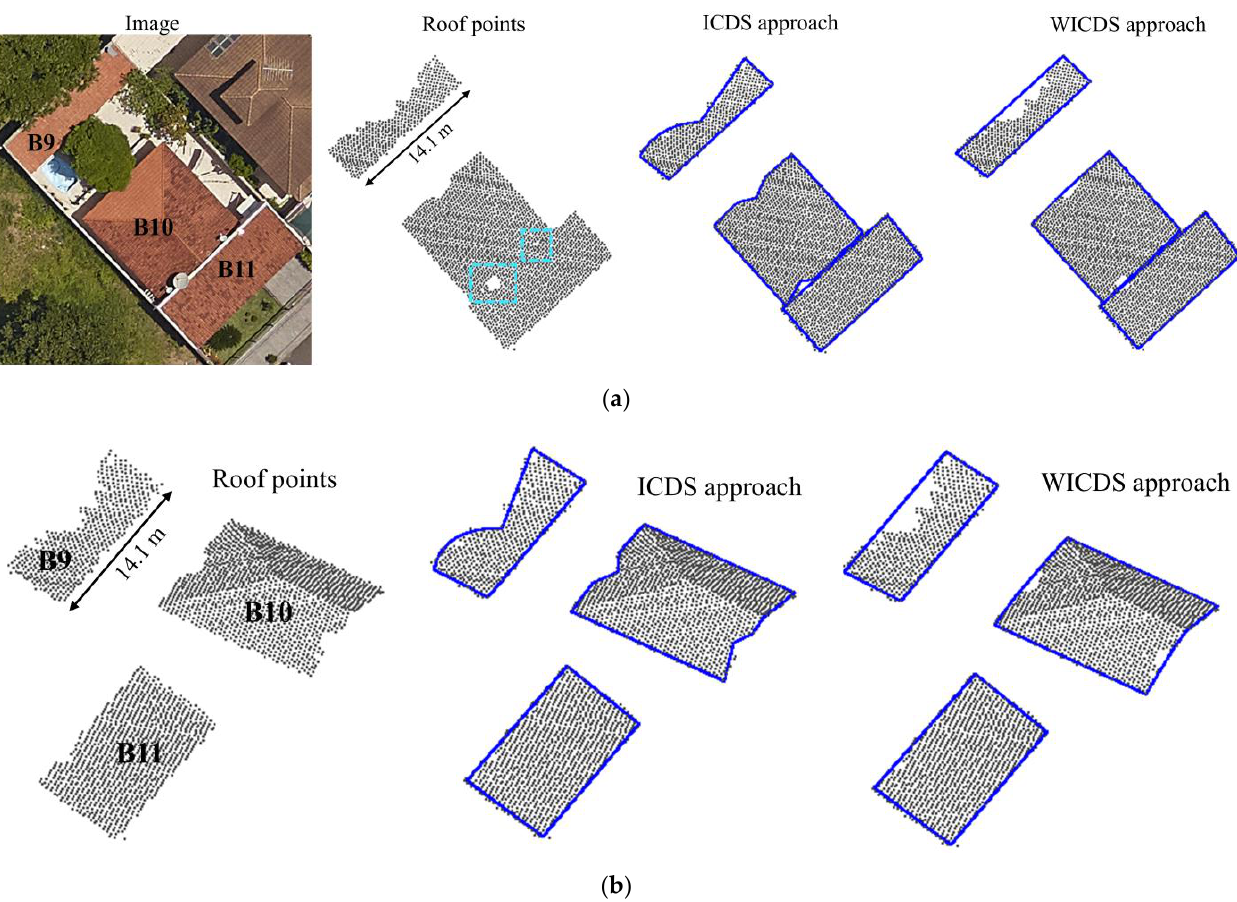
Figure 13. Two-dimensional ( a ) and three-dimensional ( b ) representations for buildings B9 – B11. First row in ( a ): aerial image patches, roof points and results derived from building modeling methods. Second row in ( b ): representation 3D of roof points and results of boundary modeling. The cyan rectangles in ( a ) highlight the occlusions caused by antennas.